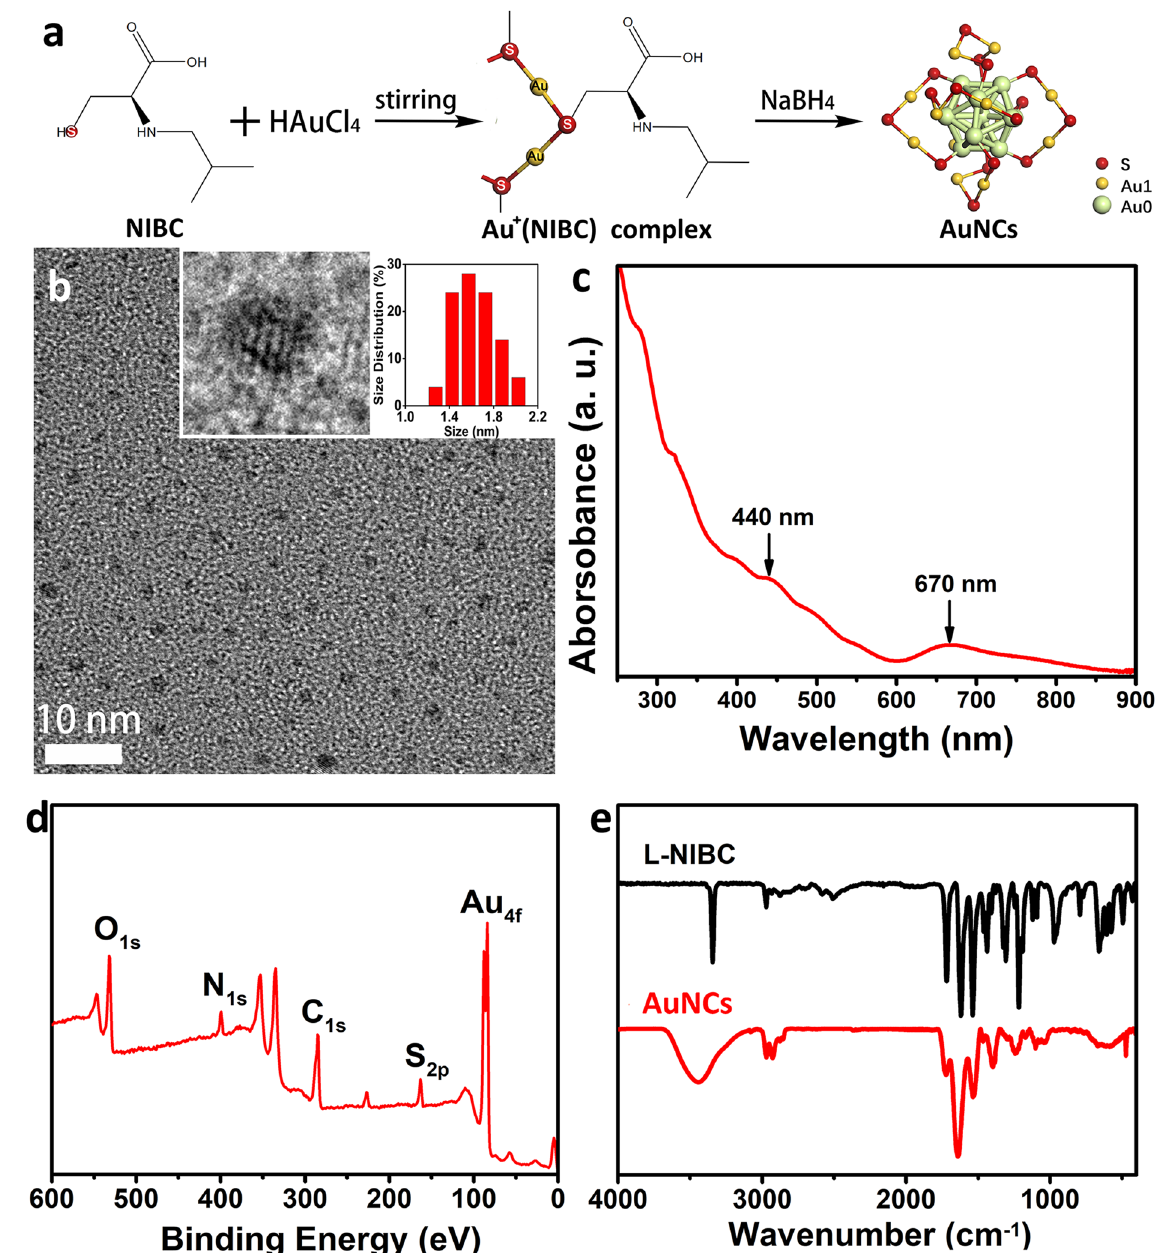
Figure 1. Scheme of synthesizing and characterization of AuNCs. ( a ) Diagrammatic flow chart showing the scheme of synthesizing of AuNCs. ( b ) TEM images, ( c ) UV–Vis–NIR absorption spectrum and ( d ) XPS survey spectrum of AuNCs. ( e ) FT-IR spectra of AuNCs and NIBC